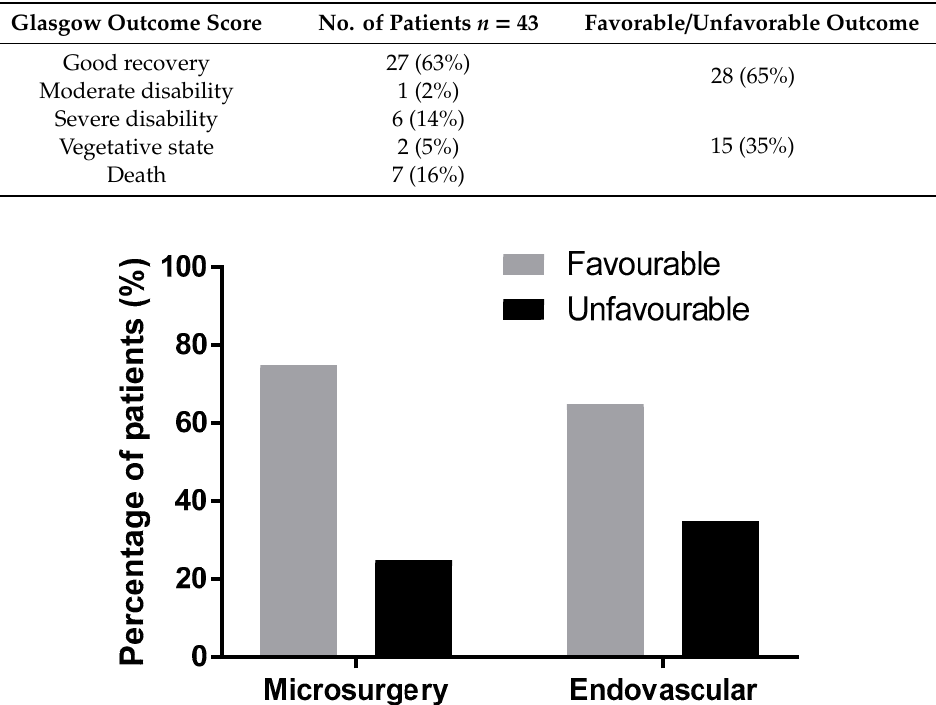
Table 4. Endovascular treatment outcome of patients three months after SAH from ACoAA; GOS after three months.